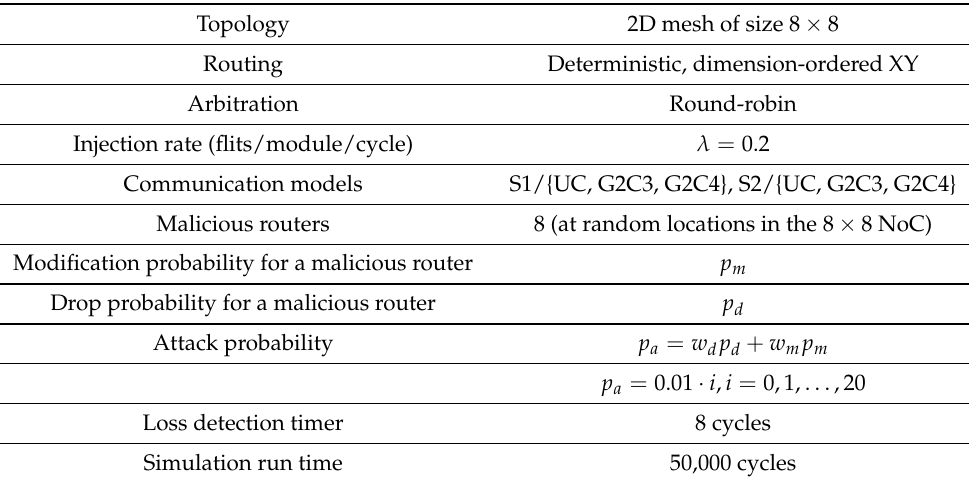
Table 2. Simulation parameters and their respective values. Topology